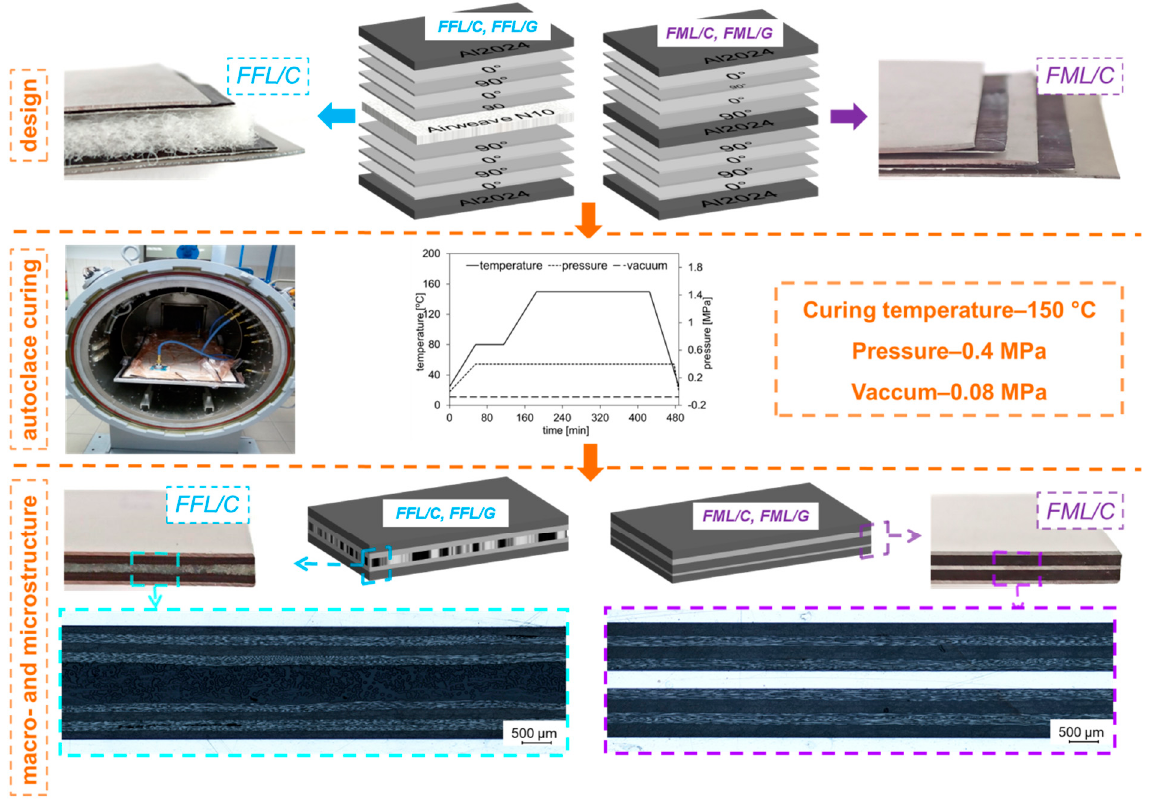
Figure 1. Lay–up scheme of FFLs and FMLs.